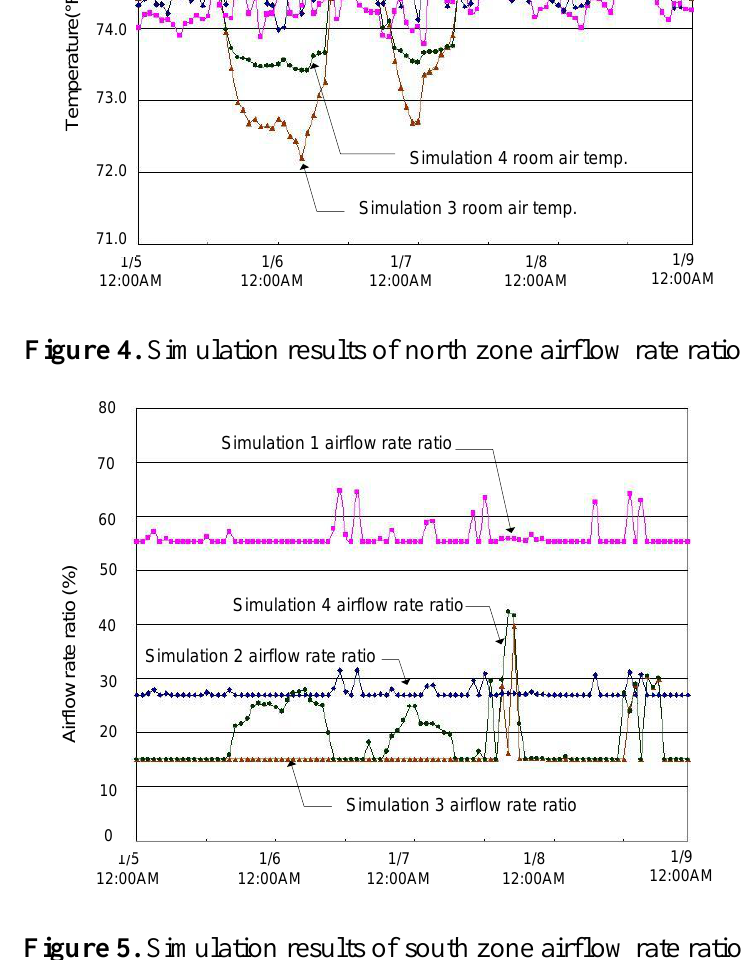
Figure 5. Simulation results of south zone airflow rate